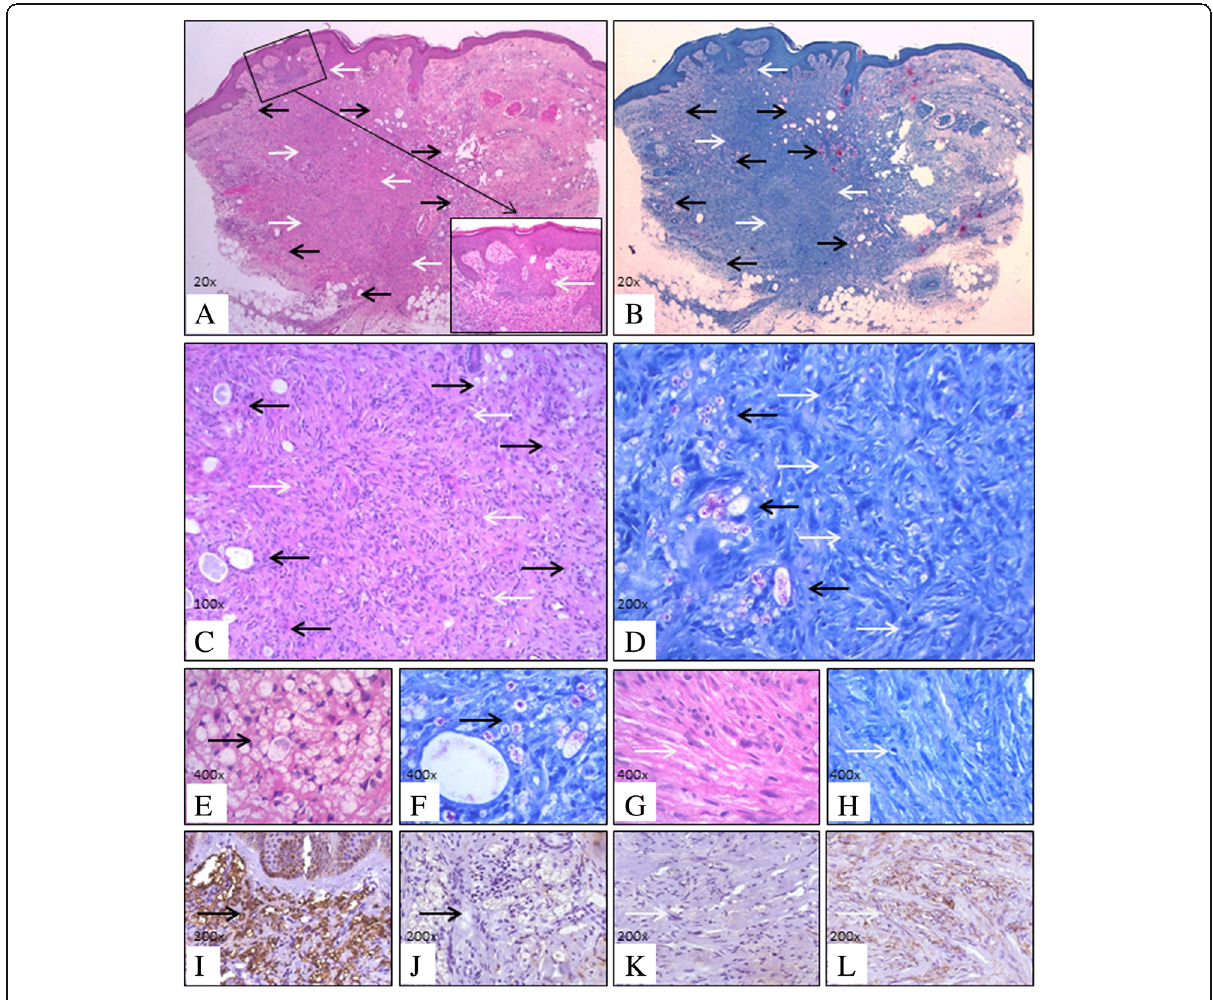
Fig. 1 Representative panel of dermatofibroma originating in a leprosy lesion: a , c , e , and g Hematoxylin-eosin-stained histological section showing the dermatofibroma in the center (light arrows) and the leprosy lesion in regression at the periphery (dark arrows); b , d , f , and h histological section for bacilloscopy (Fite-Faraco) showing absence of bacilli in the dermatofibroma (clear arrows) and presence of fragmented bacilli in the leprosy lesion in peripheral regression (dark arrows); i , j , k , l basic immunohistochemical panel – expression of anti-CD68 ( i ) in leprosy lesion macrophages and the absence of anti-factor XIIIa expression in the same macrophages ( j ); the absence of anti-CD68 expression ( k ) and the expression of anti-factor XIIIa in dermatofibroma